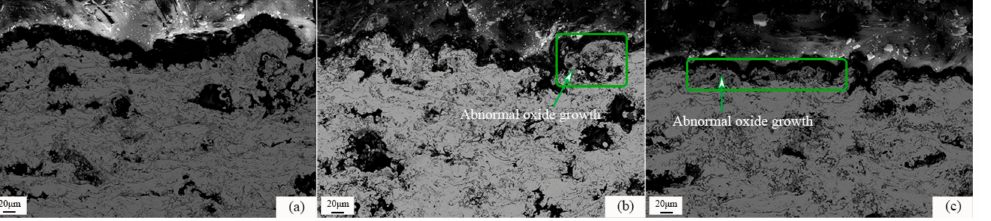
Figure 7. SEM images of the coatings after static oxidation at ( a ) 620 ◦ C; ( b ) 650 ◦ C; and ( c ) 700 ◦ C for 100 h.